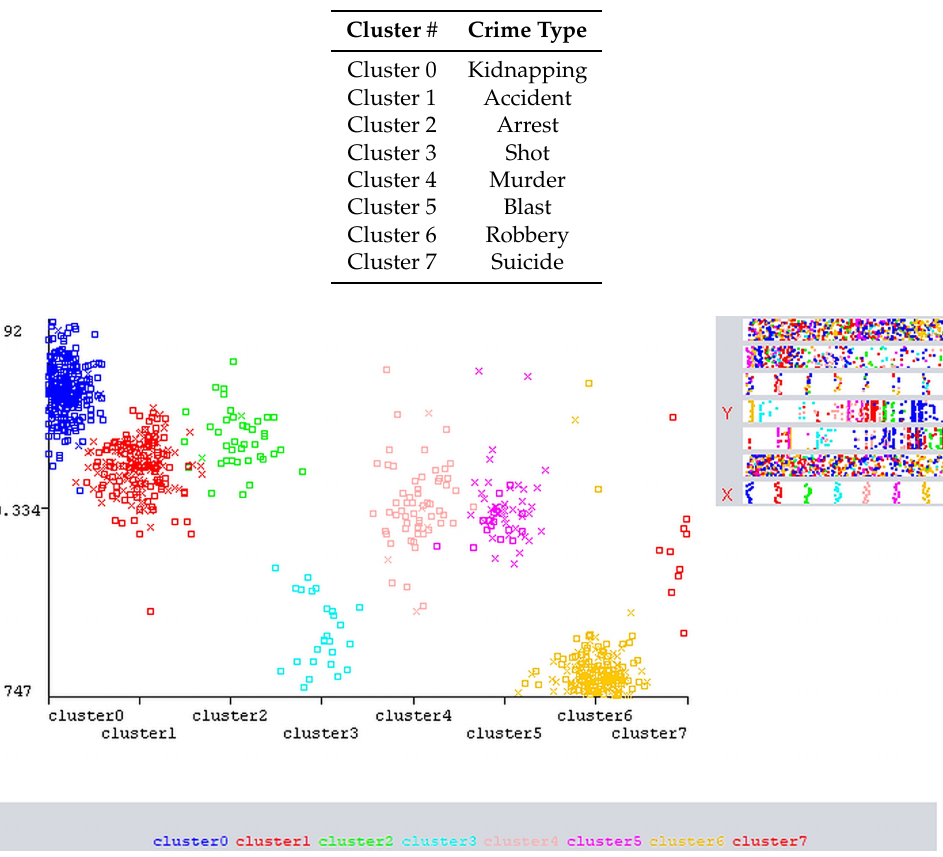
Table 5. Description of our selected feature selection methods for comparison.